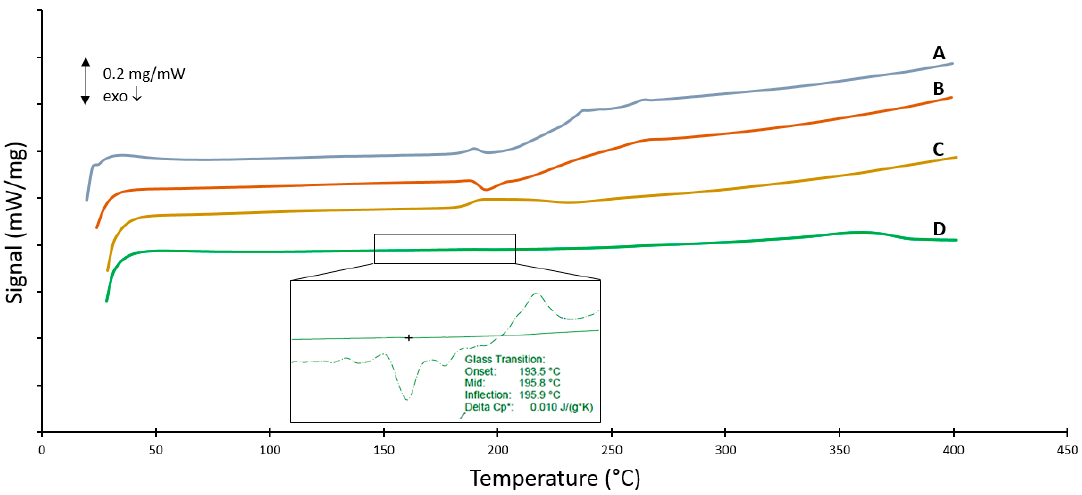
Figure 8. First heating run of DSC measurements on ( A ) spray-dried powder obtained at best parameter settings; ( B ) rotor milled powder subjected to the three step refinement process with additional sieving at 80 μ m; ( C ) virgin PSU and ( D ) fine powder obtained after 10 min of ball milling the PSU pellets.